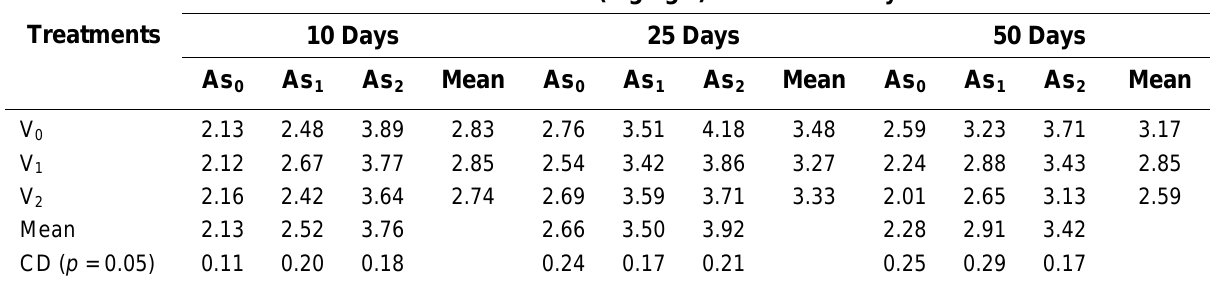
Effect of Vermicompost on the Mobilization of Arsenic (mg kg –1 ) in the Soil